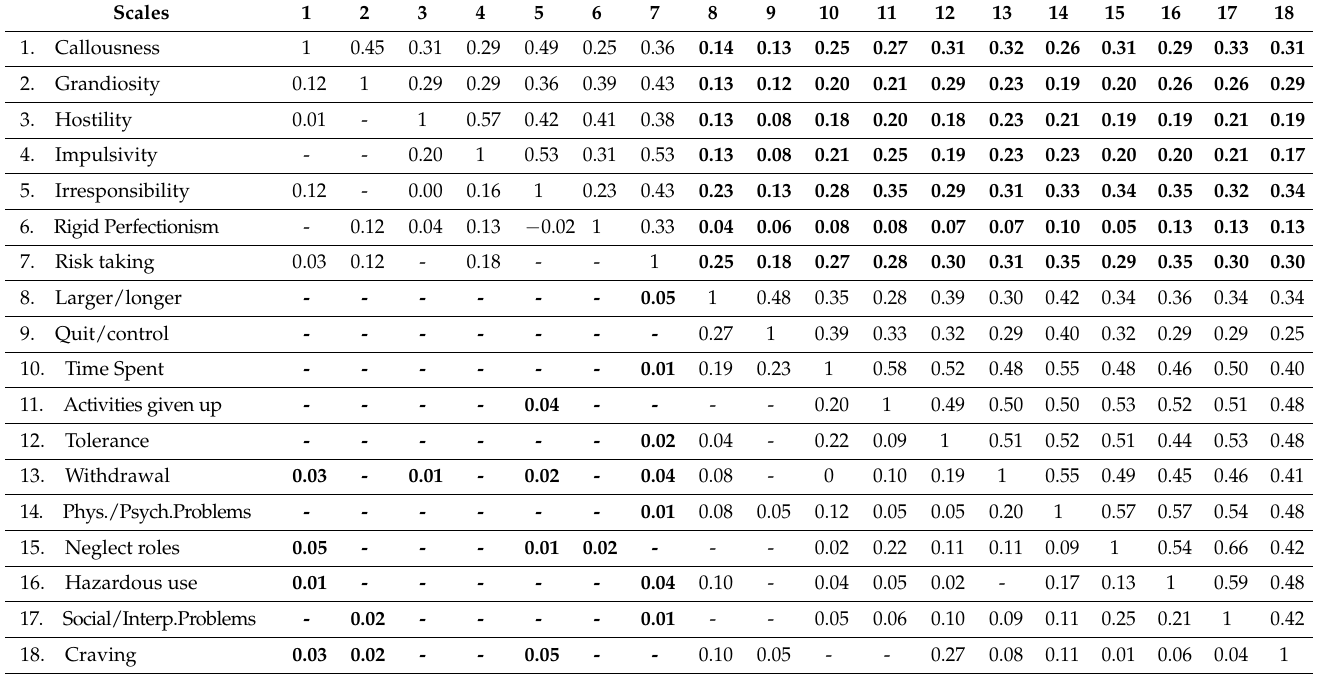
Table 5. Partial and zero-order correlations between network symptoms on estimation